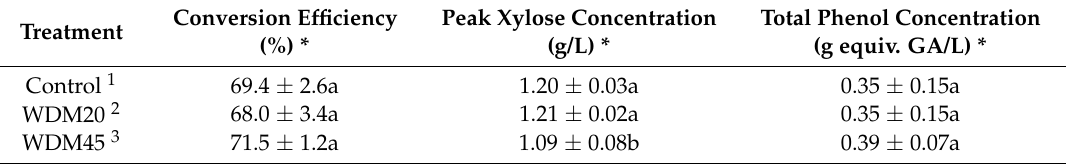
Table 4. Effect of wet disk milling on conversion, peak xylose concentrations and total polyphenol concentrations after SSF.